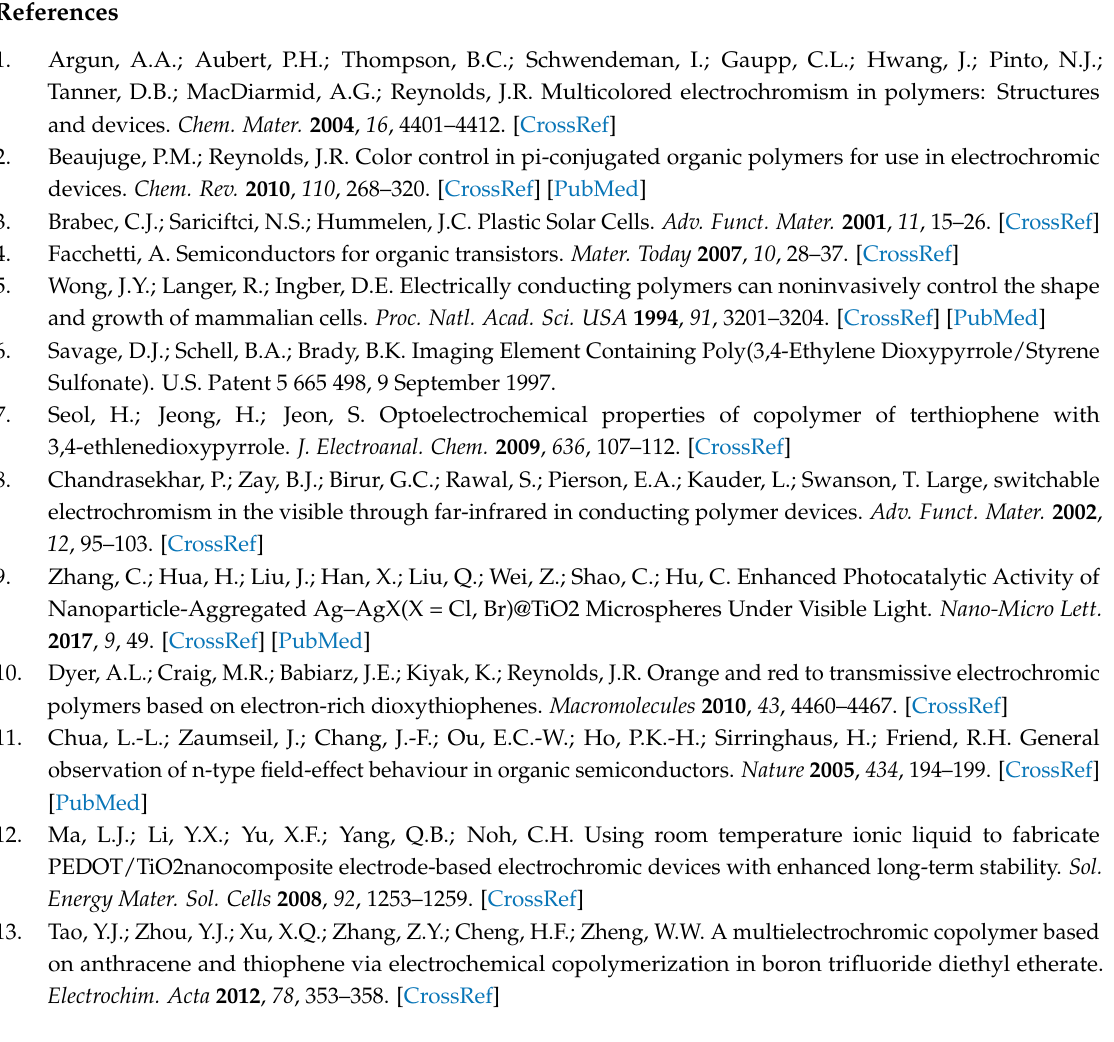
Figure A6. Raman spectra of the polymer deposits obtained during electrochemical polymerisation of In-HT, Cz-HT and Fl-HT in the presence of 10 vol % boron trifluoride diethyl etherate.